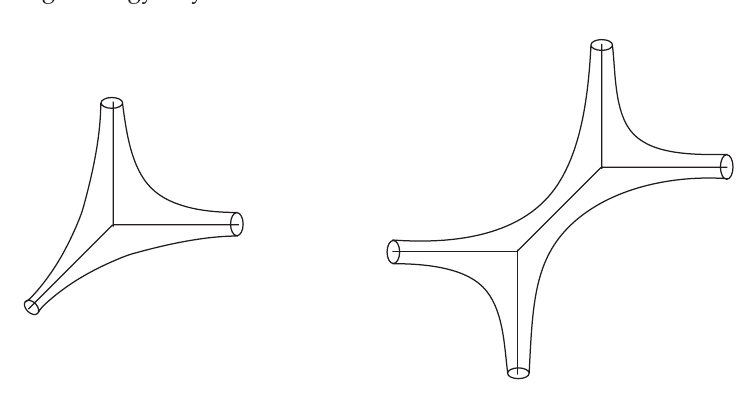
Figure 6: Toric diagrams for C 3 and conifold and corresponding mirror